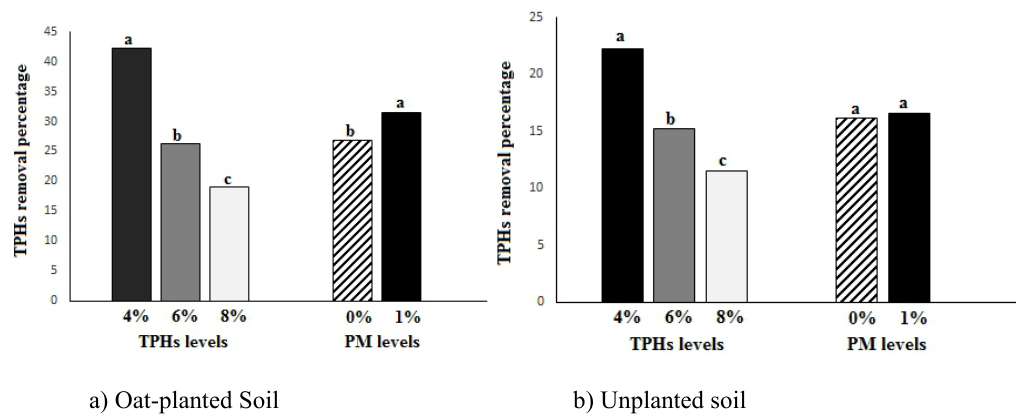
Fig. 3. Effects of TPH levels and PM on mean TPH removal rate in planted and unplanted soil Note: Mean values followed by the same letters are not significantly different (P≤0.05) according to Duncan’s multiple range